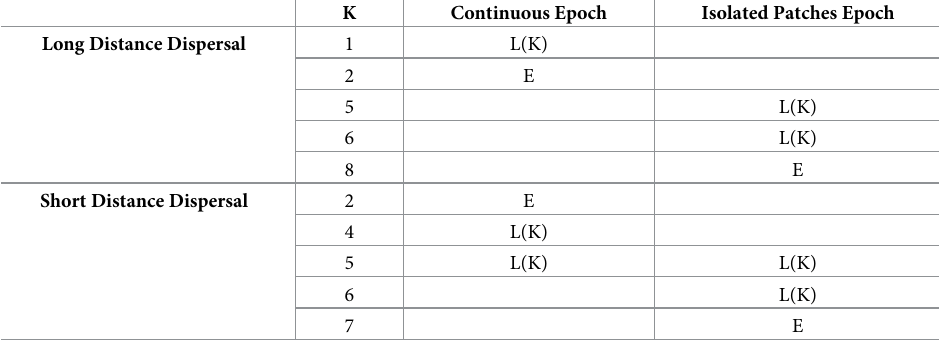
Table 3. Inferred number of genetic subpopulations K resulting from either the visual interpretation of likelihood probabilities L(K) or from Evanno’s Δ K method E , as a function of dispersal distance and epoch. When a single method produced multiple equally-supported estimates of K, then all values were included.